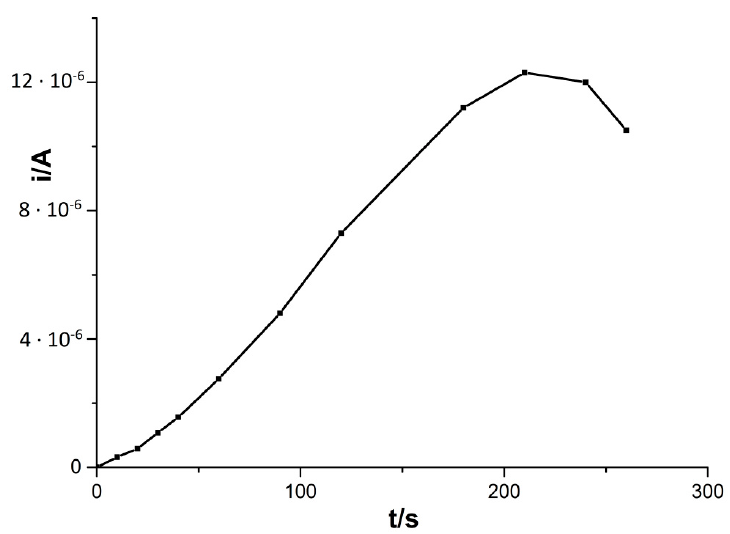
Figure 2. Influence of accumulation time on the Cd(II) signal. Composition of solution 5 × 10 − 8 M Cd(II), 2 × 10 − 4 M Cu(II), and 0.1 M HCl. Accumulation potential − 0.7 V.